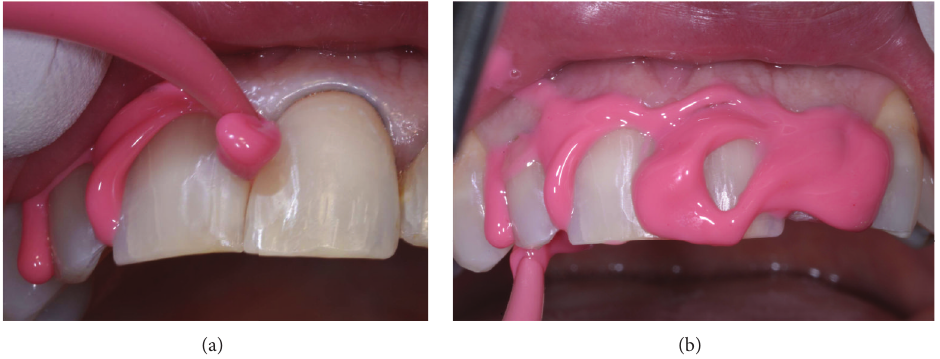
Figure 9: (a)-(b) Impregum Duosoft light body material injection.